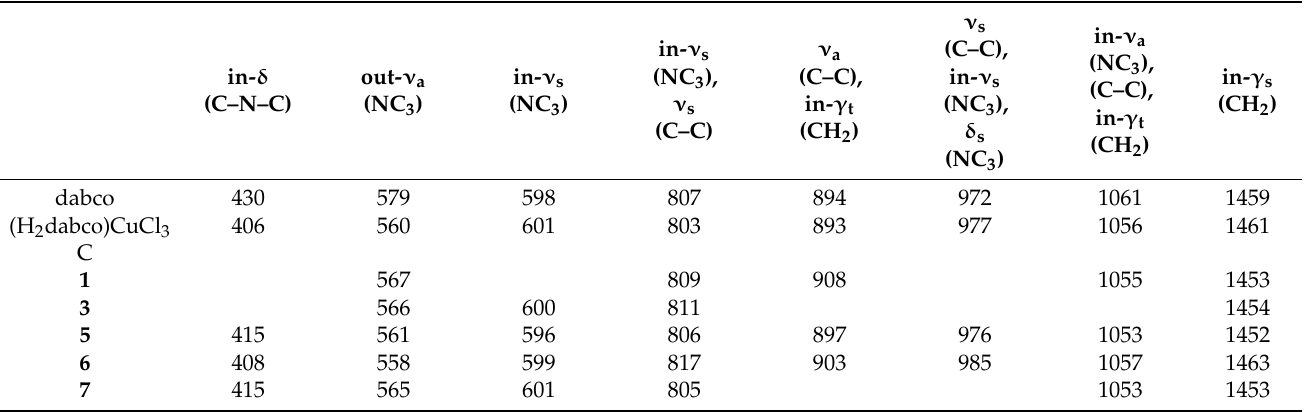
Table 2. Originated from the organic part peaks observed in Raman spectra of 1 , 3, and 5 – 7 com- pounds, pure dabco, and (H 2 dabco)CuCl 3